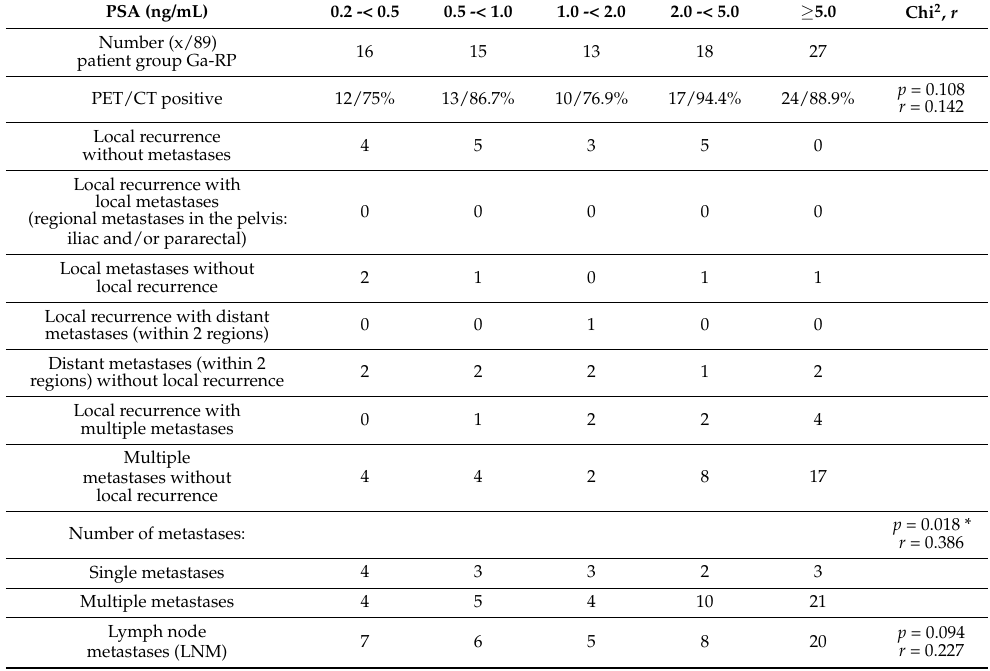
Table 6. Position of detectable cancerous lesions in [ 68 Ga]Ga-PSMA-11 PET/CT patients (pretreated with radical prostatectomy/Ga-RP) with relation to